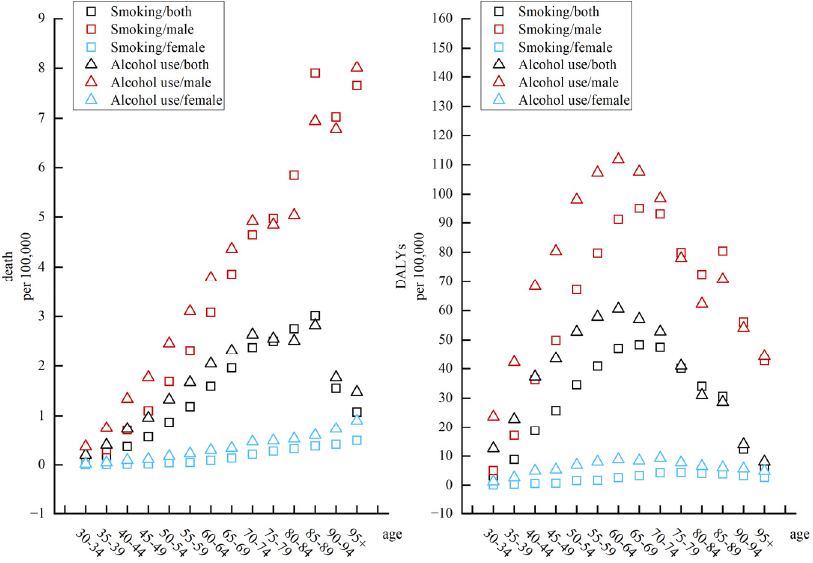
Figure 3. The variation trends of ASDR and age-standardized DALY rates of two risk factors in different genders and age groups in 2019.